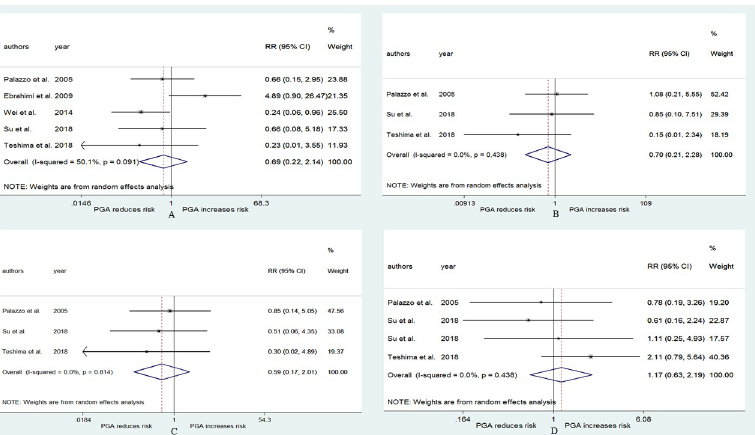
Fig 7. RR for permanent hypoparathyroidism in patients who underwent different number of PGA. (A) two or more vs one or less. (B) two or more vs one. (C) two or more vs zero. (D) one vs zero.